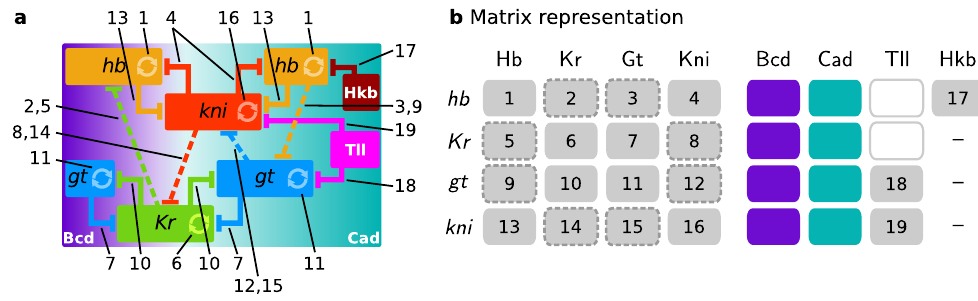
Figure 3. Gap gene network representations. ( a ) Diagram of the gap gene network as shown in Figure 1, with interactions between the expression domains along the A–P axis. Each number refers to an interaction in panel b; ( b ) Matrix representation. Column names are regulators (proteins), row names are gap genes (gene names) receiving the regulation. Gap-gap and terminal-gap interactions are numbered 1–19, and maternal gradients are coloured to match the background gradients in panel a. The gap-gap interactions with a dashed border are depicted as a net regulatory effect from one gap gene to an other in panel a (as in [14]). The regulatory effect of Tll on hb and Kr (white boxes) are ignored in panel